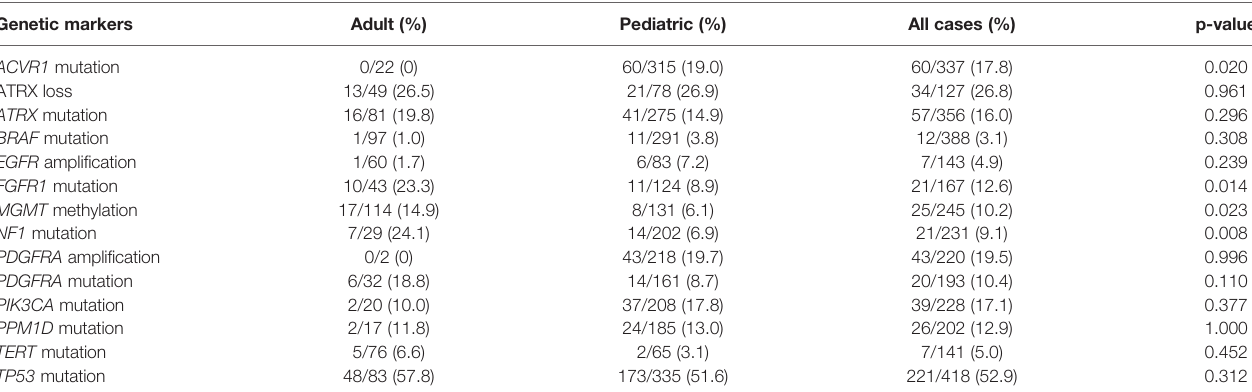
TABLE 3 | The genetic alterations of pediatric versus adult H3 K27M-mutant midline gliomas. Genetic markers Adult (%) Pediatric